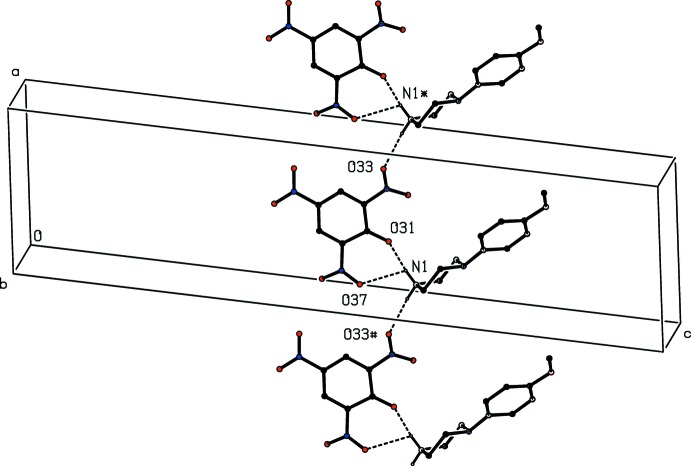
Part of the crystal structure of compound (III) showing the formation of a hydrogen-bonded chain of rings parallel to [100]. Hydrogen bonds are drawn as dashed lines and, for the sake of clarity, the minor disorder components and the H atoms bonded to C atoms have been omitted. The atoms marked with an asterisk (*) or a hash (#) are at the symmetry positions (1 + x, y, z) and (−1 + x, y, z), respectively.